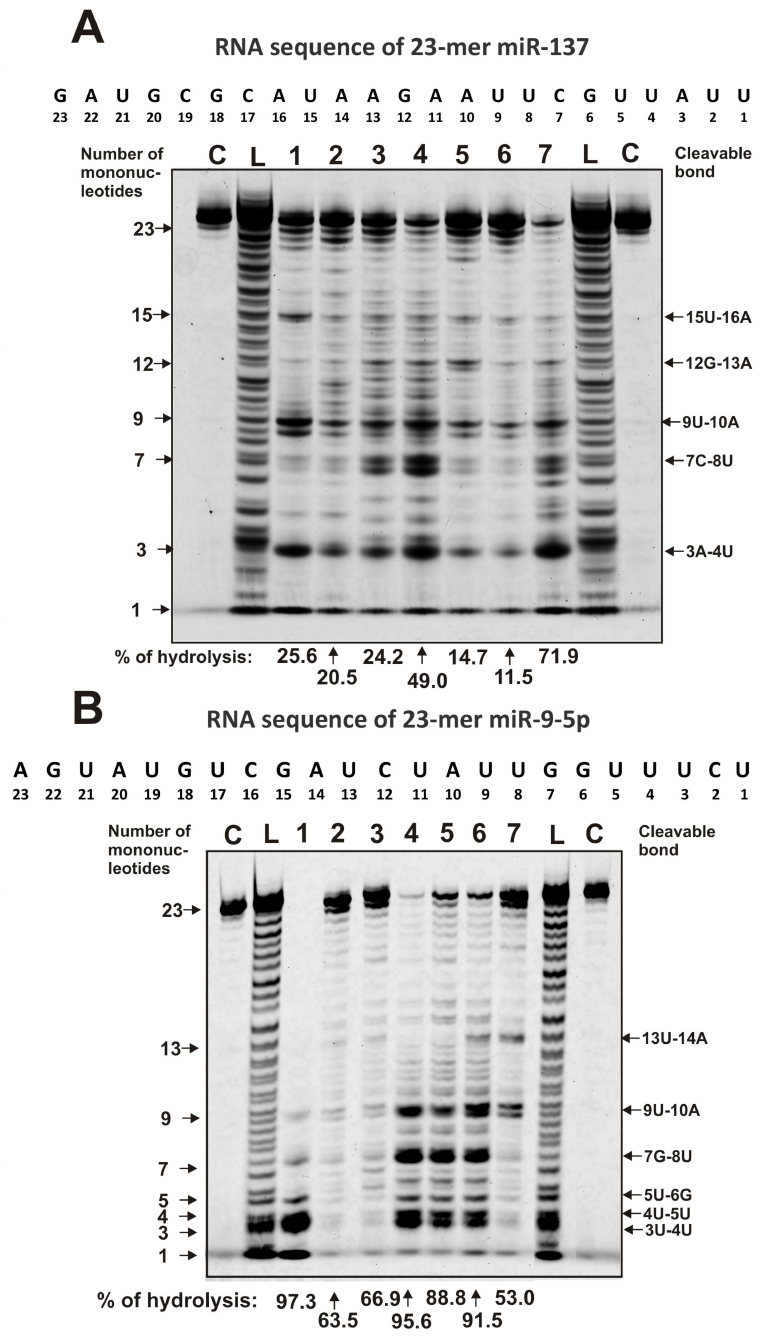
Figure 4. The patterns of 0.01 mg / mL Flu-miR-137 ( A ) and Flu-miR-9-5p ( B ) hydrolysis by seven human milk IgGs (lanes 1–7; 40 µ g / mL). The products of miRNAs hydrolysis were detected due to their fluorescence (5 (cid:48) -Flu residues) after reaction mixtures incubation for 1 h. The numbers of IgGs, lengths of the oligonucleotide products, and the percentage of miRNAs hydrolysis by each IgG preparation are indicated in panels A and B . L lanes correspond to the markers of oligonucleotides lengths, while C lanes correspond to the substrates incubated without IgGs. The percentages of hydrolysis correspond to the average values of three independent